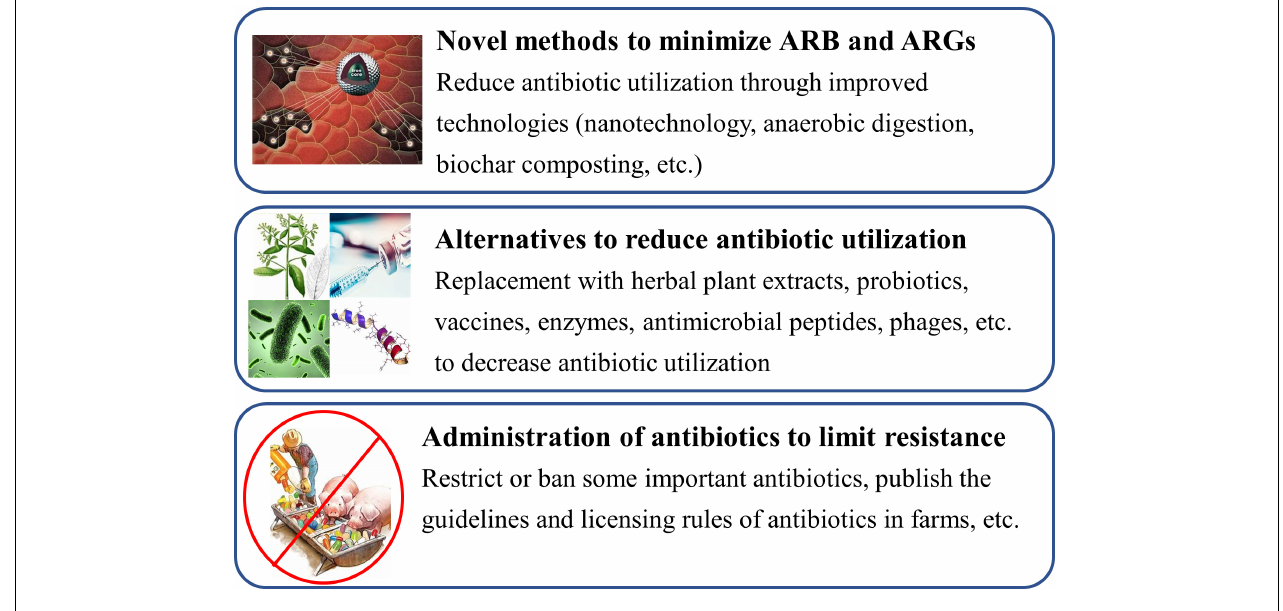
FIGURE 4 | Strategies to minimize the antibiotic resistance in food animal